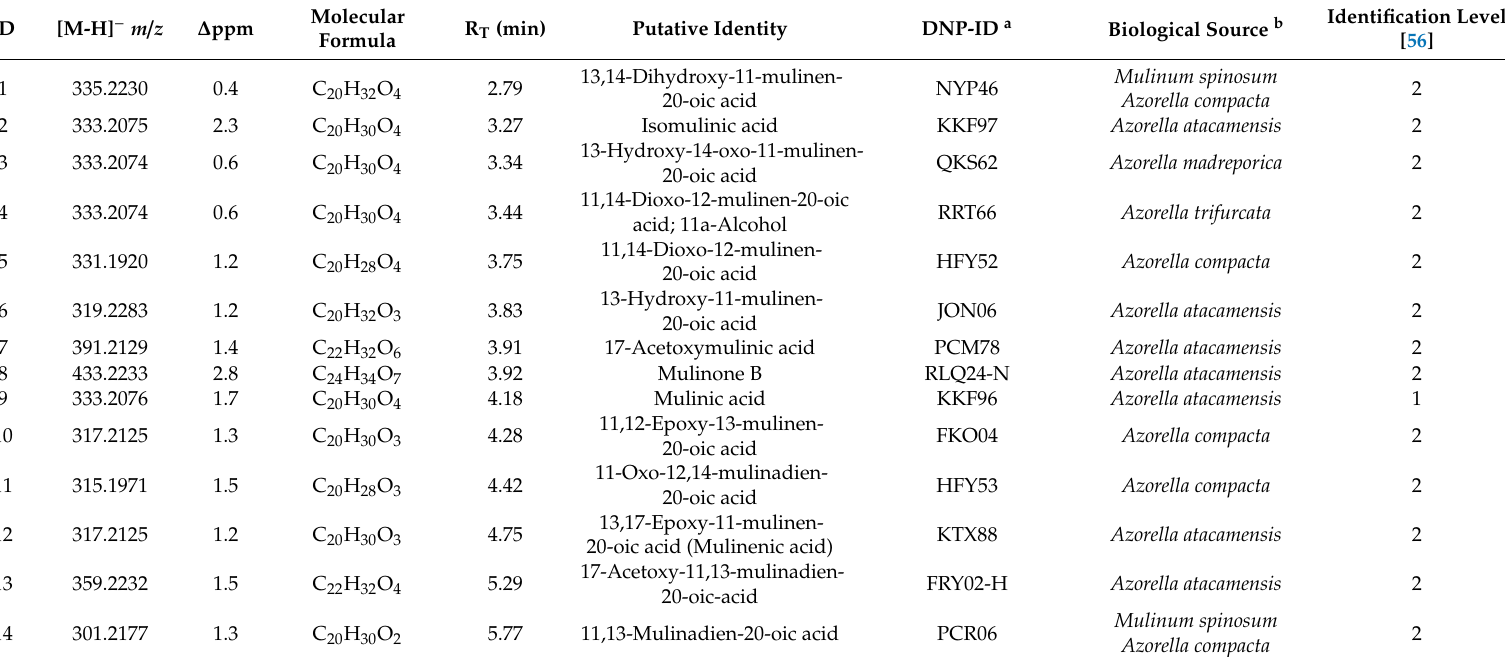
Table 1. Dereplicated compounds in the ethyl acetate extract and fractions of Azorella atacamensis